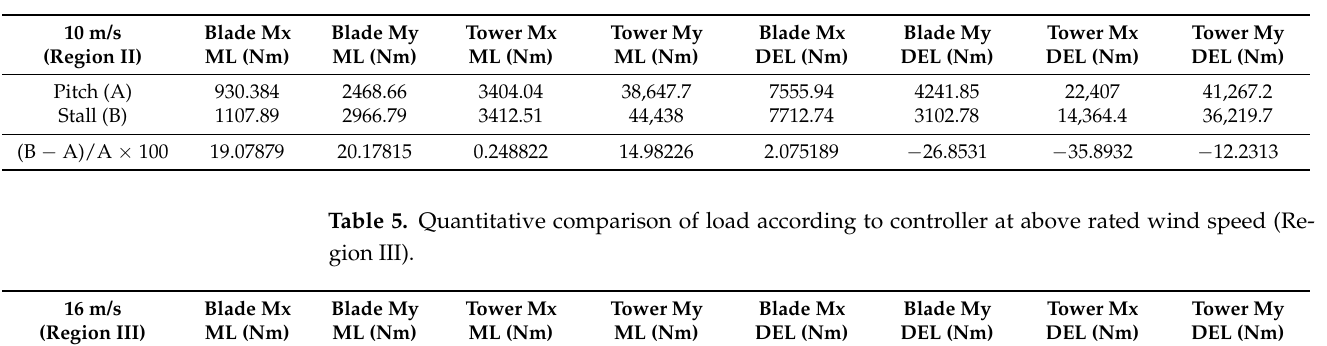
Table 4. Quantitative comparison of load according to controller at rated wind speed (Region II).